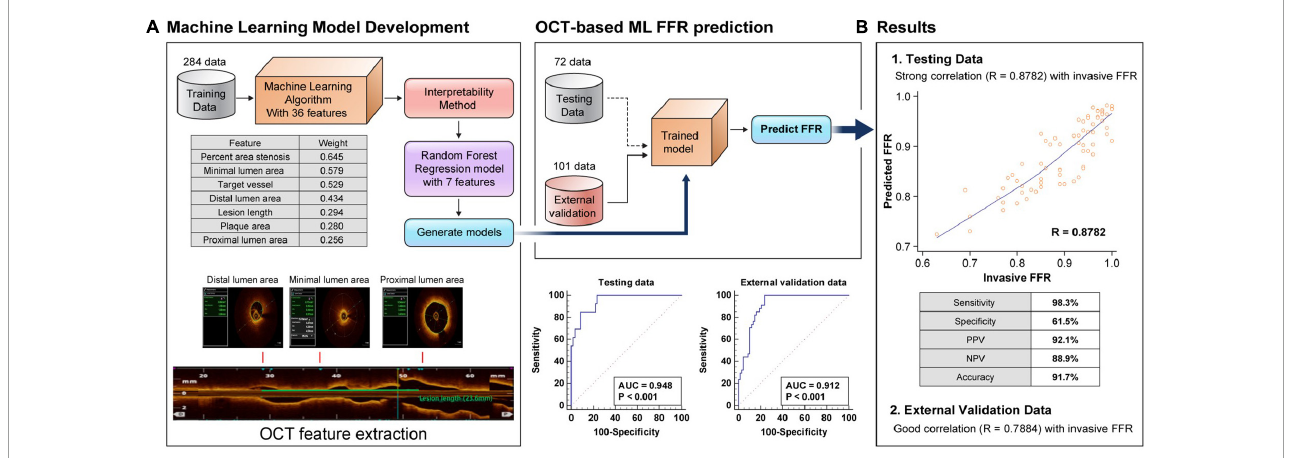
FIGURE1 Flow chart of the OCT-based machine learning method and weight of each feature (A) . Comparison between the clinical fractional flow reserve results and the predicted fractional flow reserve results in the random forest model in the testing set and external validation set, and receiver operating characteristic curve of machine learning-fractional flow reserve (B) . FFR, fractional flow reserve; AUC, area under the curve.